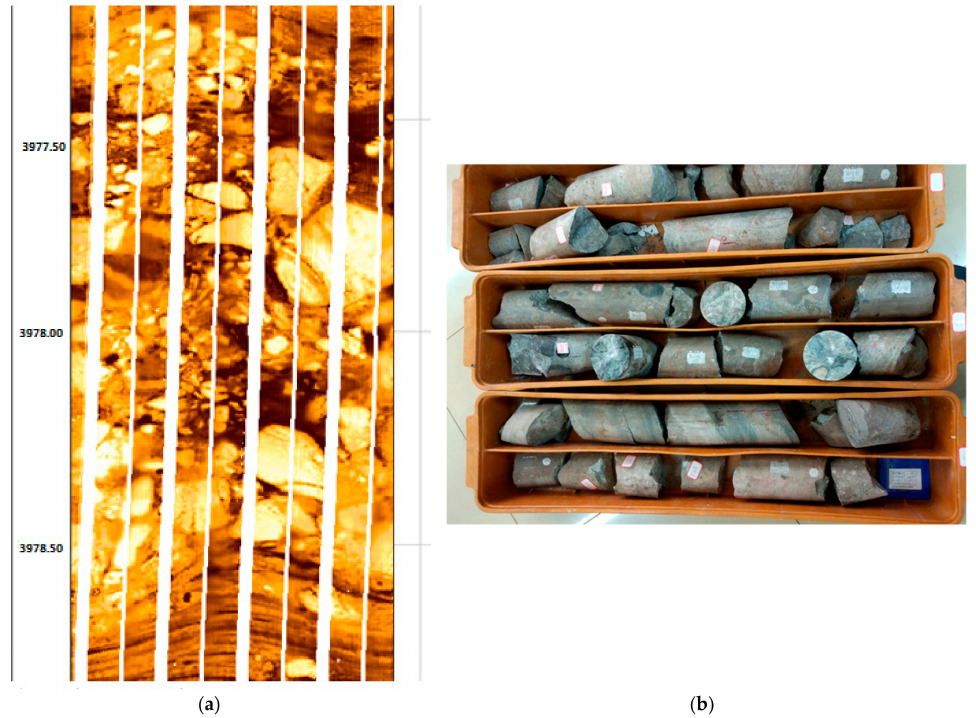
Figure 1. ( a ) The Formation MicroScanner Image (FMI) result in the Ken761 block in Dongying, Shandong province, China; ( b ) the drill cores obtained